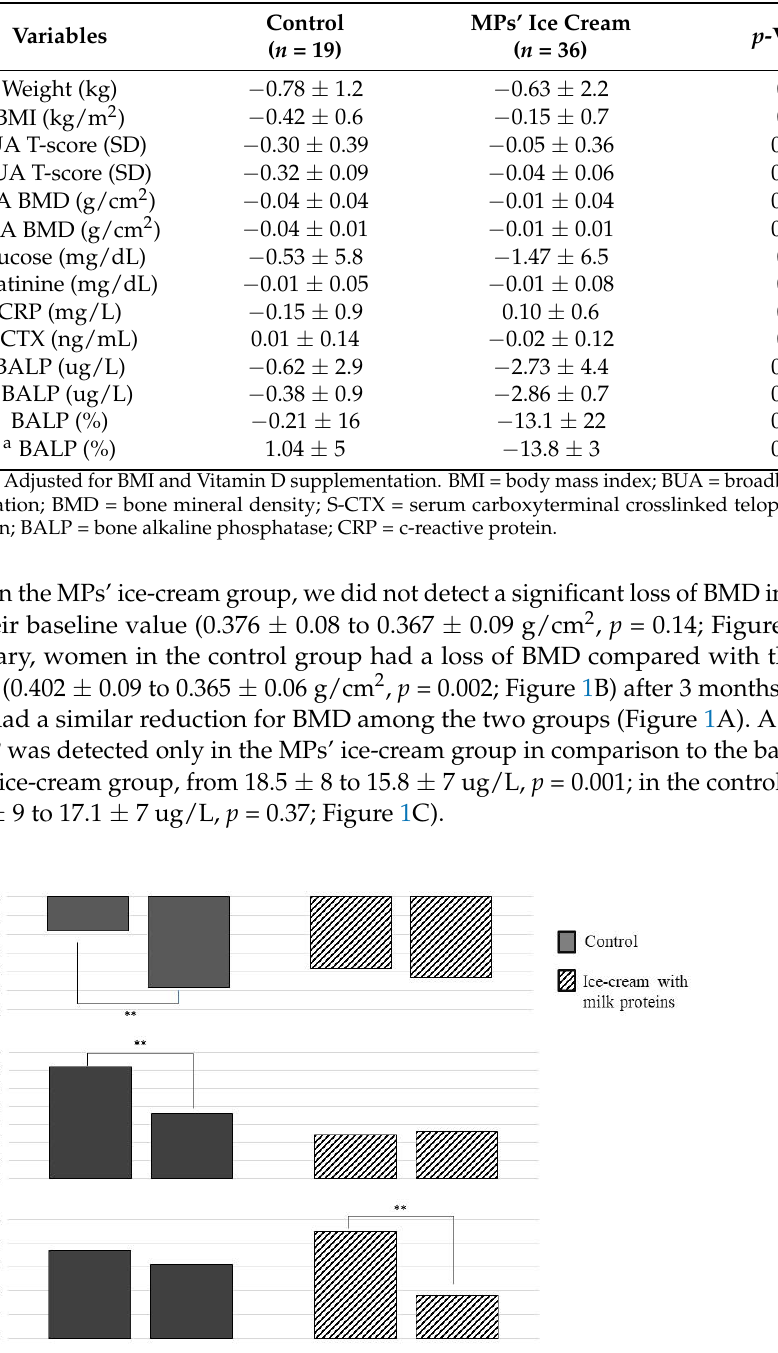
Saos-2 cells were incubated with WP 0.5; 1; 2 mg/mL for 10 min. All these doses of WP increased pERK1/2 expression compared to the control (0 vs. 0.5 mg/mL WP, p < 0.001; 0 vs. 1 mg/mL WP, p = 0.017; 0 vs. 2 mg/mL WP, p = 0.019) (Figure 2A). Figure 2B shows that only 1 and 2 mg/mL of WP increased pAKT. Moreover, WP incubation increased the protein expression levels of pERK1/2 and pAKT in a dose-dependent manner in comparison to the control (Linear Regression: p = 0.002 and p = 0.016, respectively; Figure 2A,B).